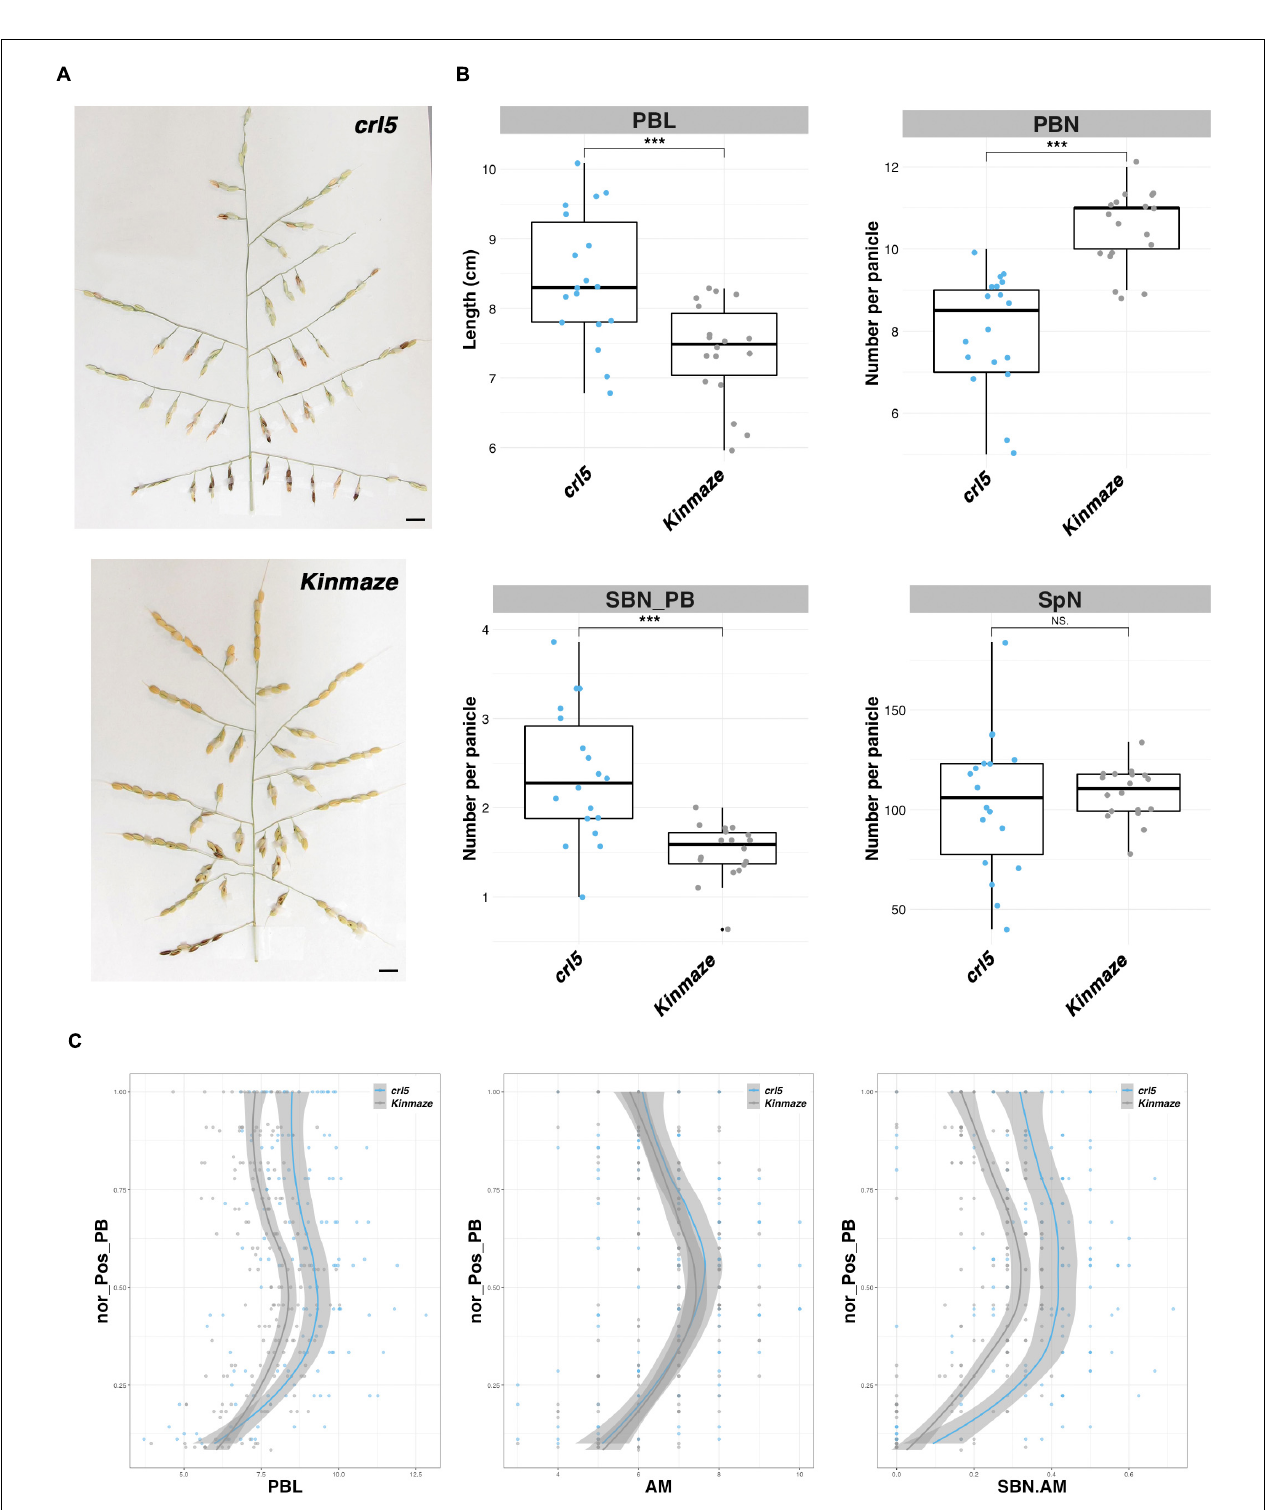
FIGURE 3 | Panicle phenotype of the crl5/plt8 mutant. (A) Mature panicles from the crl5 mutant and its wild-type background (Kinmaze). Scale bar: 1 cm. (B) Box plots with individual dots indicating the average primary branch length (PBL), the number of primary branches (PBN), the ratio between secondary branch number and PBN (SBN_PB), and the spikelet number (SpN) per panicle of the crl5 mutant, in comparison with wild-type plants of the same genetic background (Kinmaze). Individual dots in box plots correspond to average values from the three main panicles per plant. Statistical significance ( t -test p -values) between the two lines or parents for the two panicle morphological traits is indicated as follows: NS if the test is non-significant; *** p -values < 0.001. (C) Plots of normalized positions of primary branches (Nor_pos_PB) against PBL, axillary meristem number per PB (AM), and the ratio of SBN vs. AM per PB (SBN.AM).